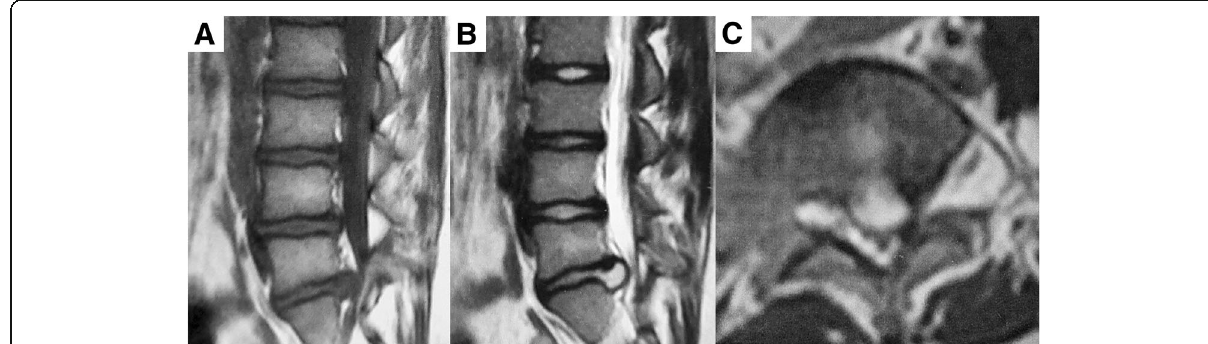
Fig. 1 a Sagittal T1, b sagittal T2, and c axial T2 of the lumbosacral spine showing the protruded disc fragment compressing the left S1